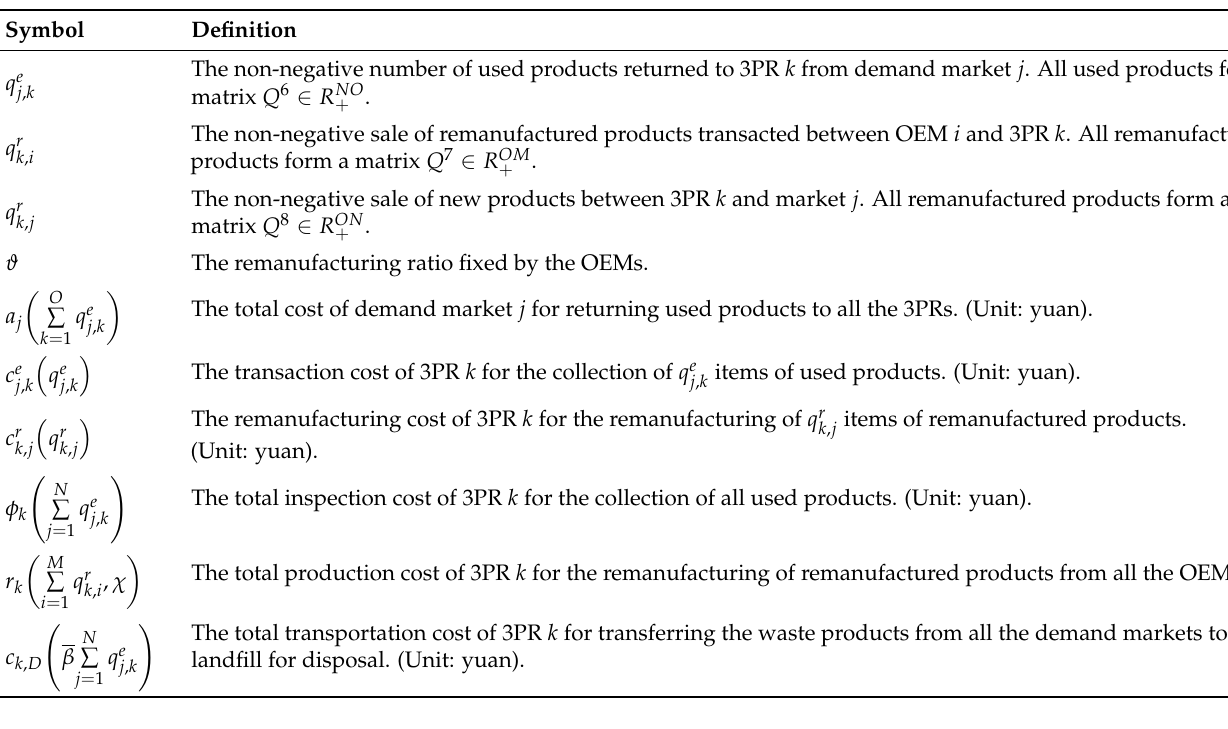
Table 5. The decision variables, parameters, and cost functions in the ARS